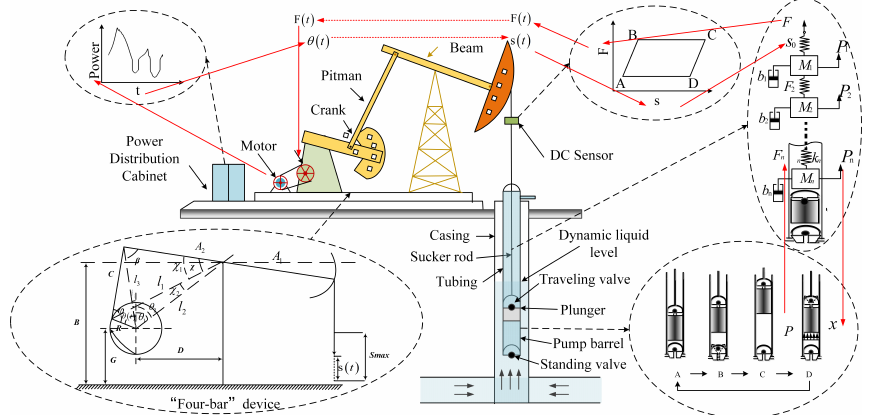
Figure 1. Sucker rod pump